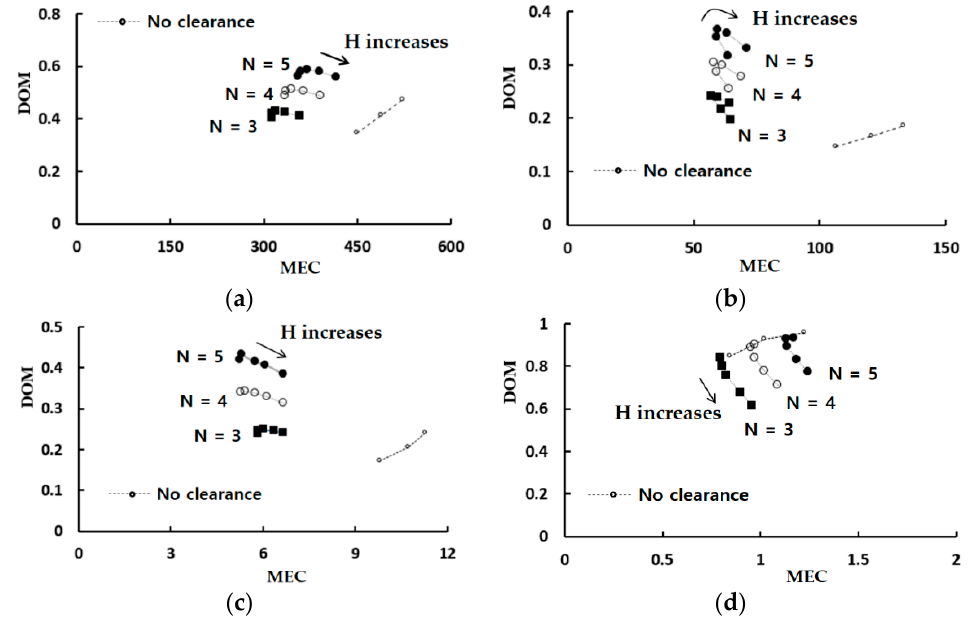
Figure 9. Mixing effectiveness map: ( a ) Re = 0.1, ( b ) Re = 1, ( c ) Re = 10, and ( d ) Re = 50.